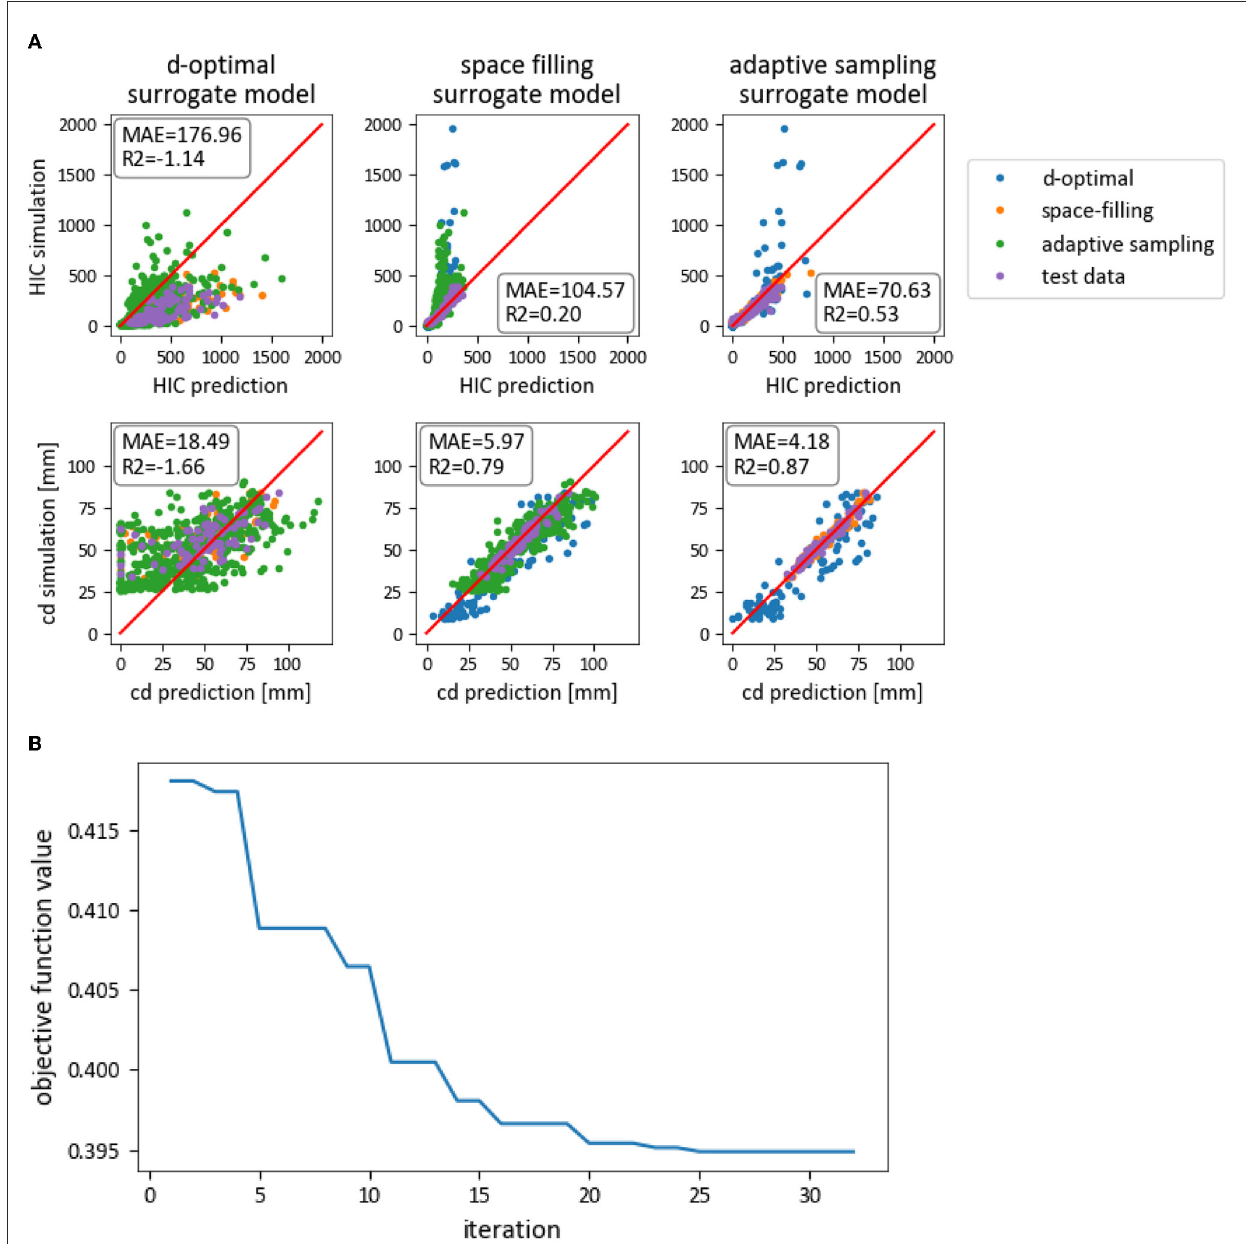
FIGURE12 (A) Validation of the developed surrogate models for HIC and chest deflection (cd) prediction on the data sets in Table 2. (B) Convergence plot of the differential evolution algorithm for one exemplary collision